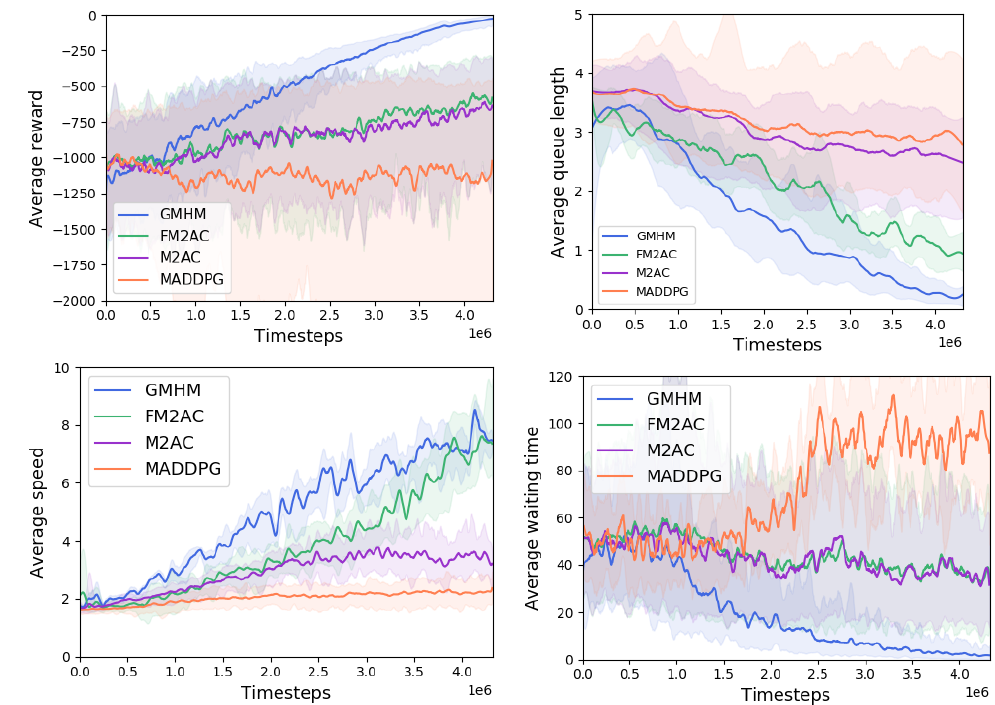
Figure 3. Experiment results in grid network . The curves in the figure show the performance of each algorithm on different